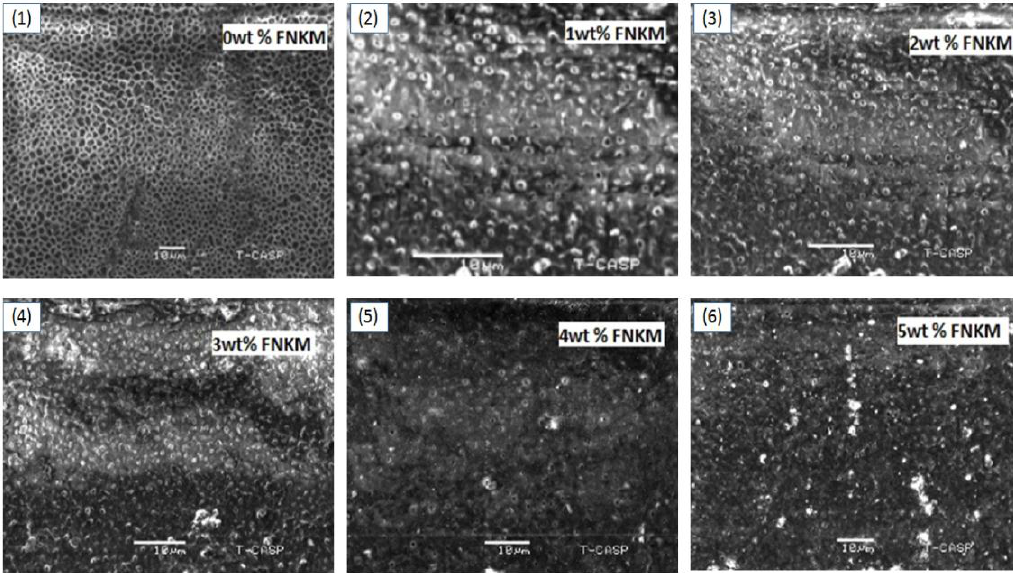
Figure 1. Scanning electron microscopy (SEM) images of cellulose acetate (CA) membranes with 0–5 wt % loading of FNKM (functionalized nanokaolin decorated multiwall carbon nanotubes).